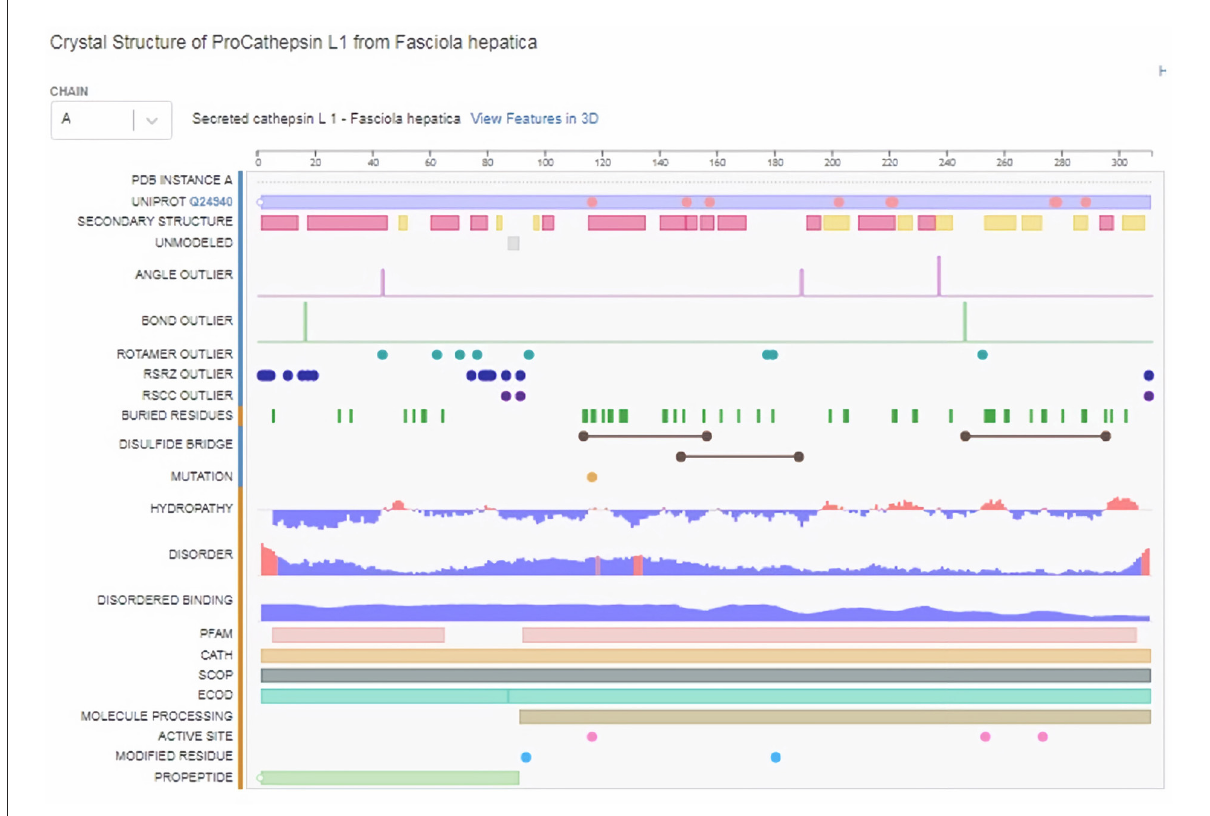
FIGURE6 Structural and physical properties of FhCatL1 protein from protein data base (PDB).